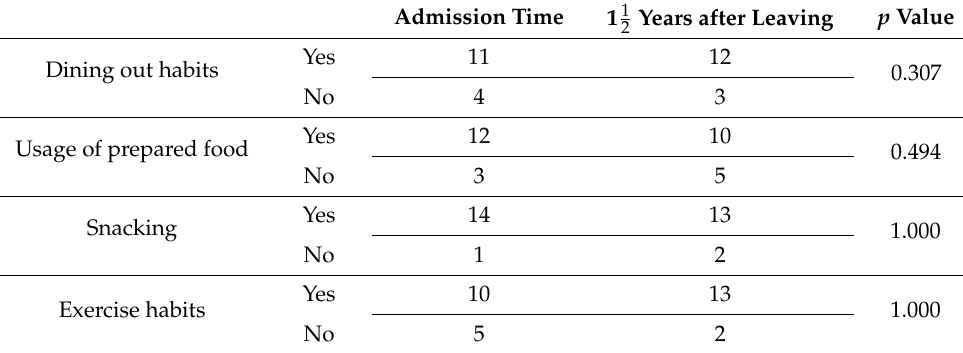
Table 2. Changes in the daily ( n = 15).